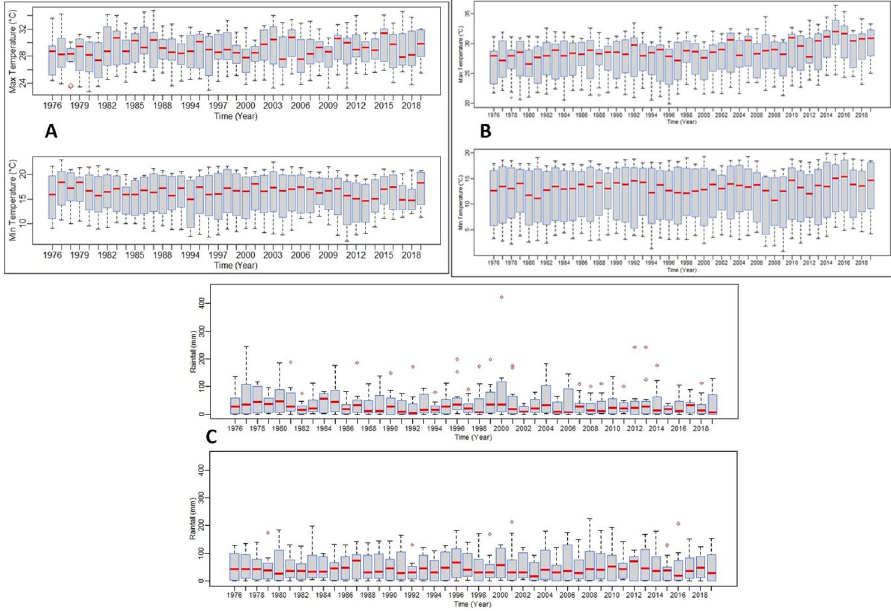
Fig 2. Boxplot of minimum temperatures (A top; B top) and maximum temperature (A bottom; B bottom) over Hoedspruit (A) and Oudestad (B) stations and rainfall (C) top District 34 and bottom District